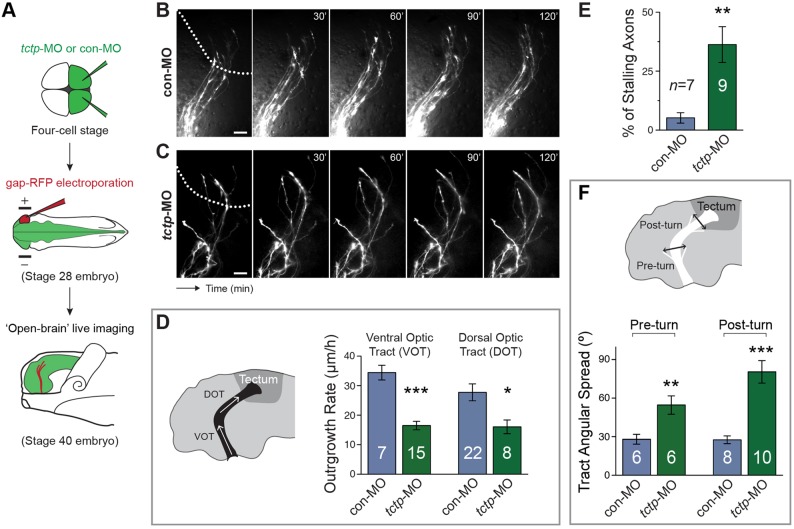
Tctp deficiency impairs axon extension in vivo. (A) Schematic of the experiment. con-MO-injected or tctp-MO-injected stage 28 embryos were electroporated with gap-RFP to label retinal axons and allowed to develop until stage 40 before in vivo brain imaging. (B,C) Representative time-lapse images of gap-RFP-labelled control (top) and Tctp-depleted (bottom) RGC axons coursing through the optic tract. Dotted lines approximate the boundary of the optic tectum. (D) Average extension rates measured from time-lapse recordings of RGC axons coursing through the ventral optic tract (VOT) and dorsal optic tract (DOT) in controls and Tctp morphants. VOT, ***P<0.0001; DOT, *P<0.0273. (E) Percentage of axons with stalled progression in the control and morphant backgrounds. **P<0.0035. (F) Retinotectal projection angular spreads in controls and Tctp morphants. Pre-turn, **P<0.0082; post-turn, ***P<0.0001. (D-F) Mean±s.e.m.; n, number of axons (D) or embryos (E,F) analysed; unpaired t-test. Scale bars: 25 μm.